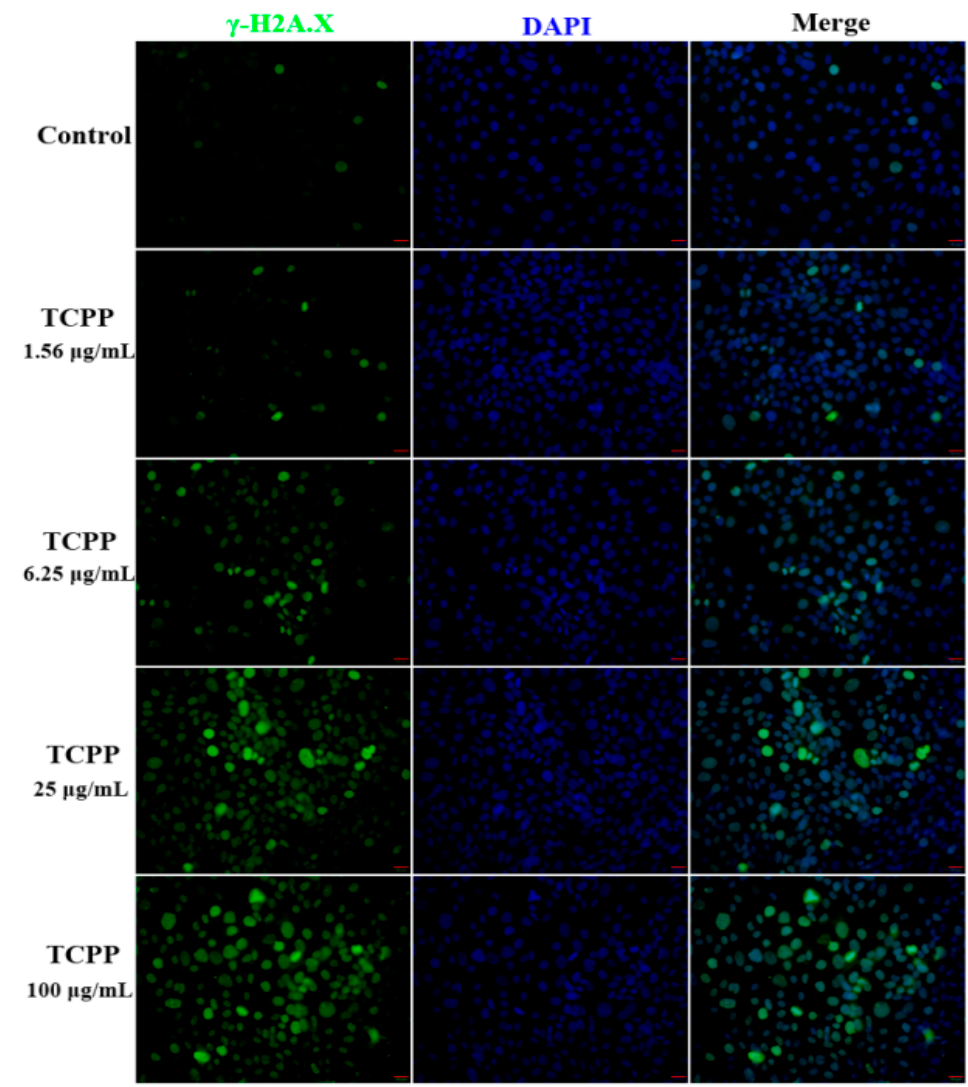
Figure 4. TCPP induced DNA damage in HaCaT cells after exposure to 1.56–100 μ g/mL TCPP for 24 h. The green fluorescence intensity of γ -H2AX (green) was elevated by increasing TCPP concentration in HaCaT cells, suggesting aggravation of DNA damage. DAPI counterstains the nuclei (blue), 200× magnification. Scale bar 20 μ m.